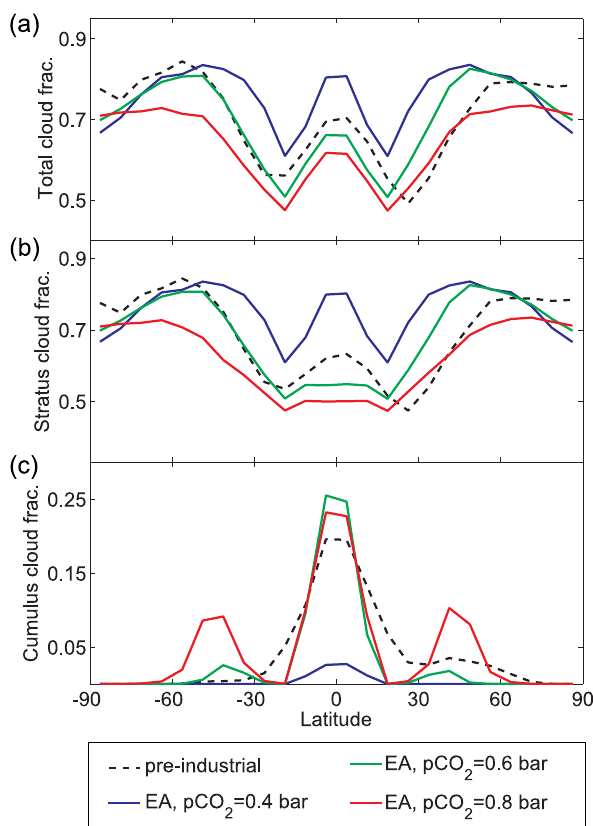
Fig. 8: Annual and zonal mean total cloud fraction in the pre-industrial climate and the three early Fig. 8. Annual and zonal mean total cloud fraction in the pre- industrial climate and the three early Archean climate states: (a) to- Archean climate states: (a) total fraction, (b) stratus cloud fraction, (c) cumulus cloud fraction. tal fraction, (b) stratus cloud fraction, (c) cumulus cloud fraction.